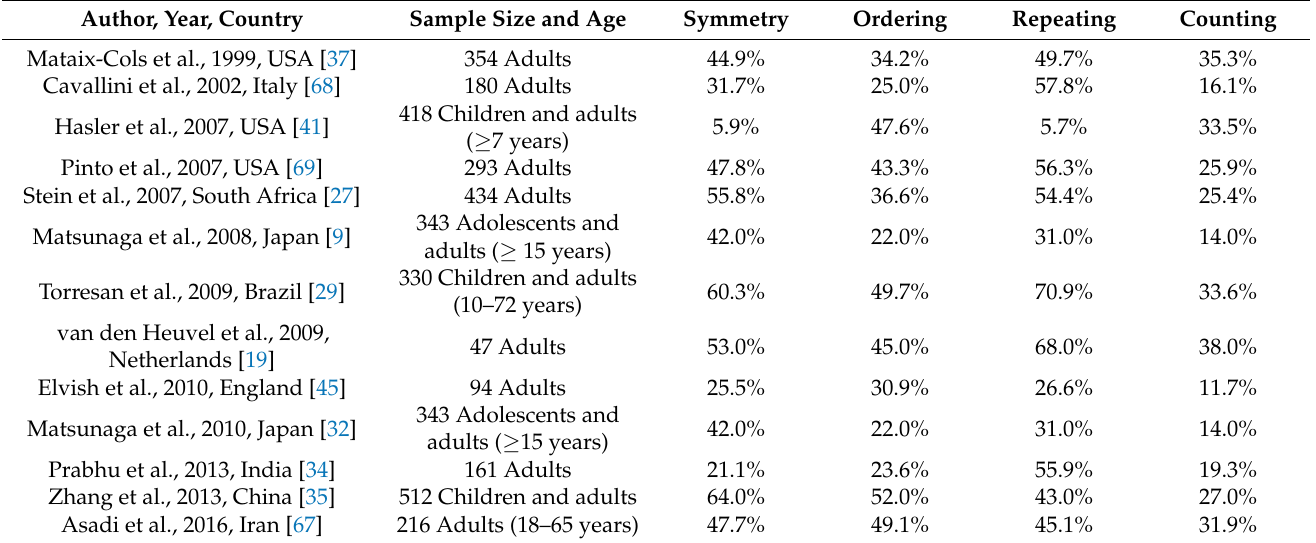
Table 5. Studies describing the frequency of symmetry-related symptoms in OCD patients according to the Y–BOCS or CY–BOCS symptom